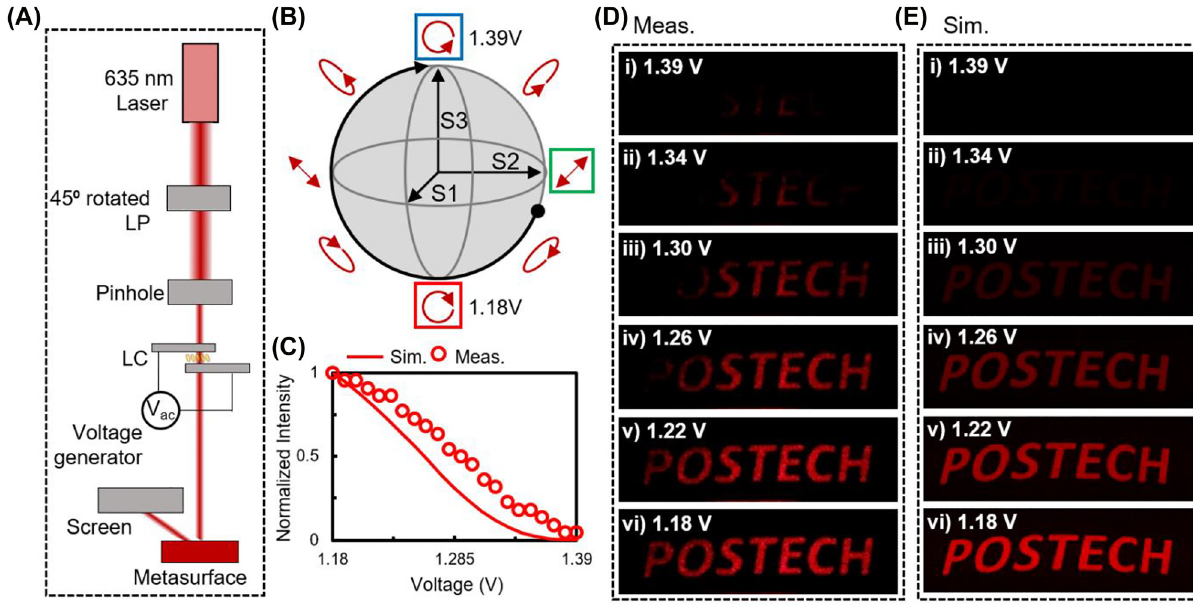
Figure 5: Demonstration of electrically-tunable intensity using LC-assisted spin-selective chiral metasurfaces. (A) Schematic of the optical setup forelectrically-tunable intensity with LC-assisted spin-selective chiralmetasurfaces. (B) Outputpolarization statespass throughthe LC when45 ° rotatedlinearlypolarizedlightisincident.Green,red,andbluesquares:Incidentandoutputpolarizationstateswhen V ac is1.18and 1.39 V, respectively. Black dot: polarization states at V ac = 0 V (C) Calculated (solid line) and measured (dotted line) intensity of metaholo- grams. (D) Measured and (E) simulated continuous intensity-tunable holograms when V ac were (i) 1.39 V, (ii) 1.34 V, (iii) 1.30 V, (iv) 1.26 V, (v) 1.22 V, and (vi) 1.18